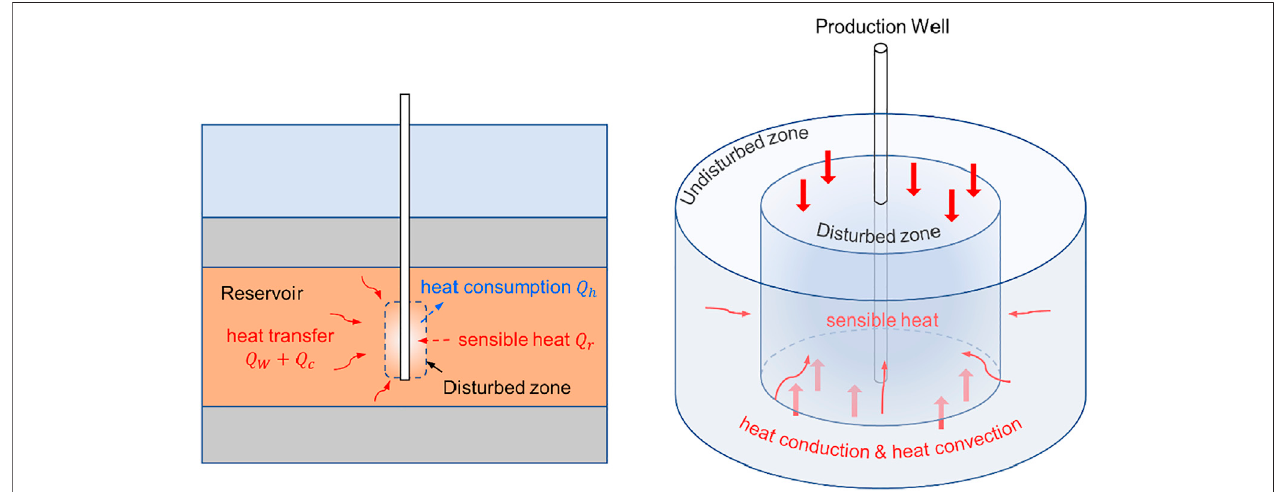
FIGURE 1 | Schematic diagram of the thermodynamic processes during hydrate production.